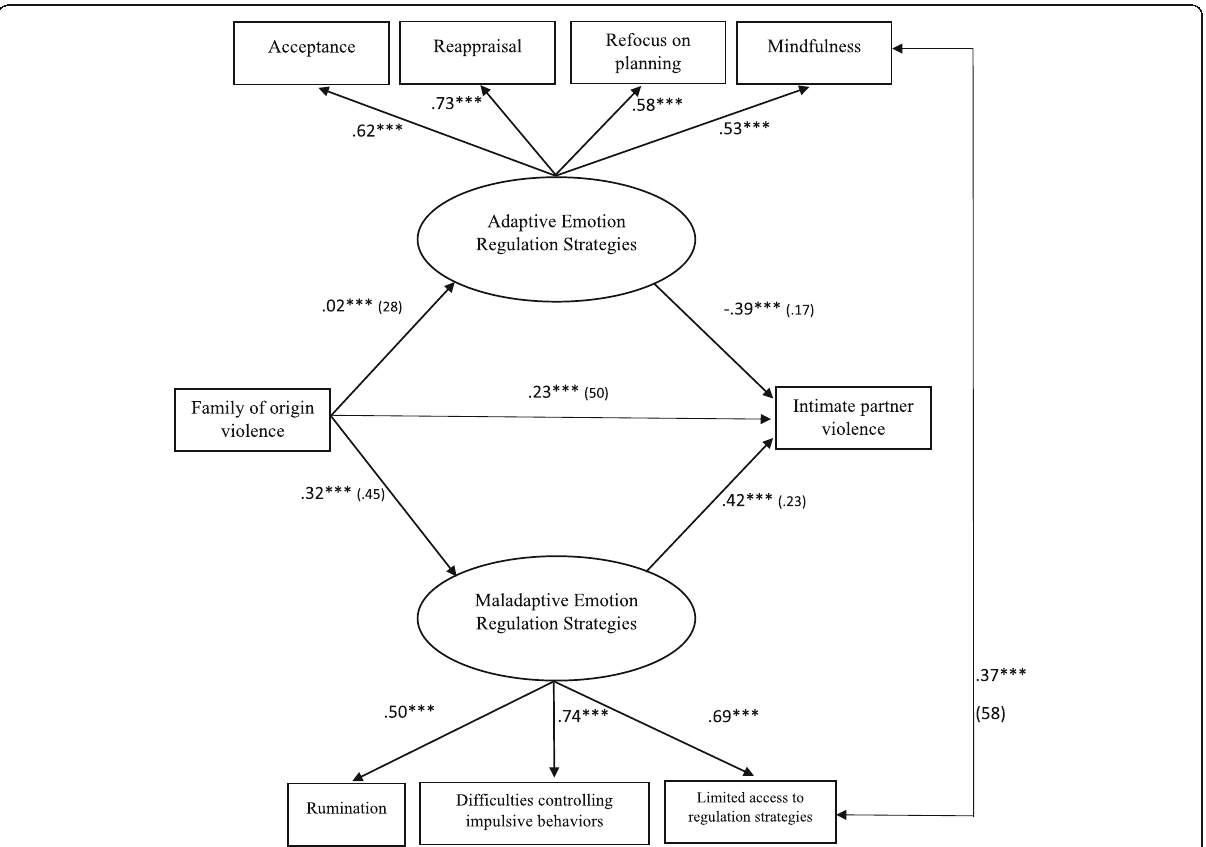
Fig. 2 Final structural model for women. Mediating effects of emotion regulation strategies on the relation between family of origin violence and intimate partner violence. Values on paths correspond to the standardized regression coefficients. Standard errors are presented in parenthesis. The maladaptive emotion regulation strategies were a significant mediator. *** p <